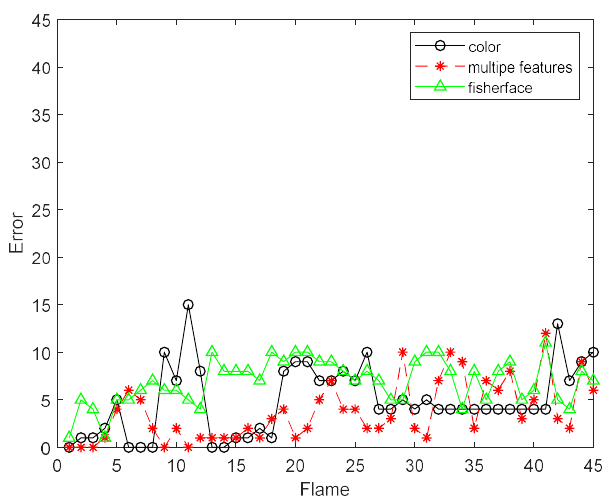
Figure 20. The RMSE comparison corresponding with Fisherface.